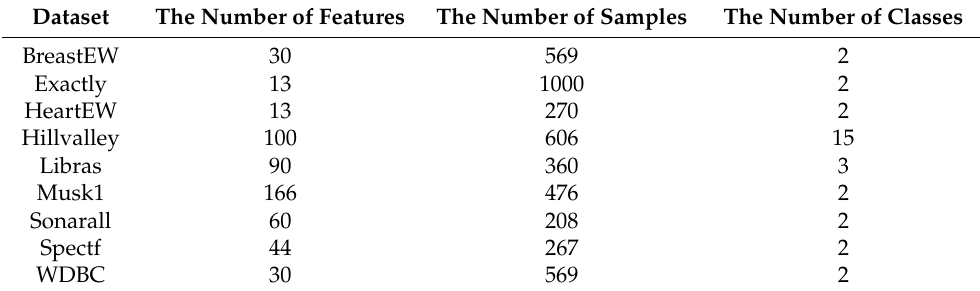
Table 1. Dataset